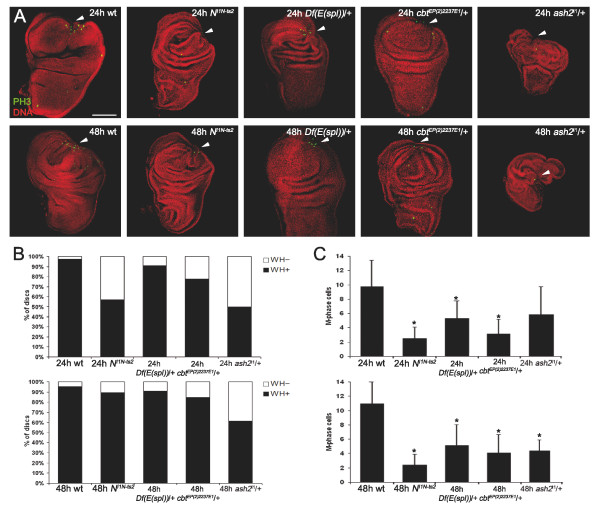
Involvement of the Notch pathway, cbt and ash2 in wing imaginal disc regeneration. Wound healing (WH) and mitosis (M) in blastemas of Notch pathway, cbt and ash2 mutants. (A) Regenerating imaginal discs from wild-type (wt); NI1N-ts2; Df(E(spl))/+; cbtEP(2)2237E1/+; and ash2I1/+. Staining of mitosis (green) and nuclei (red). Scale bar = 100 μm. Upper panels show 24-hour regenerating discs; lower panels, 48-hour regenerating discs. Arrowheads point to the wound vertex. (B) Percentage of discs with correct wound closure (black) and absence of closure (white). (C) Number of M-Phase cells in the blastema region at 24 and 48 hours. Asterisk indicates differences between wt and mutants discs (P value < 0.005).